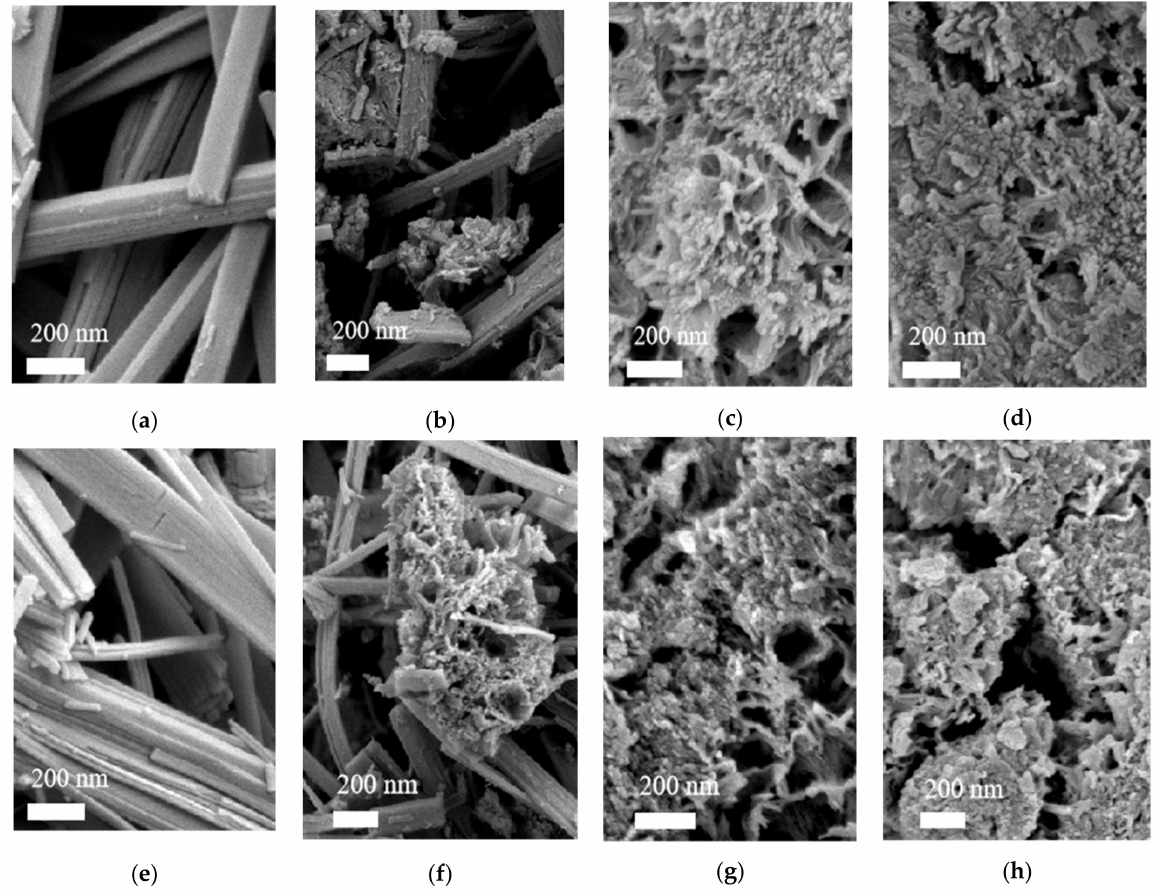
Figure 2. SEM, TEM, and HRTEM images of the samples: Scanning electron microscopy (SEM) images of the ( a – d ) intermediate products and ( e – h ) final